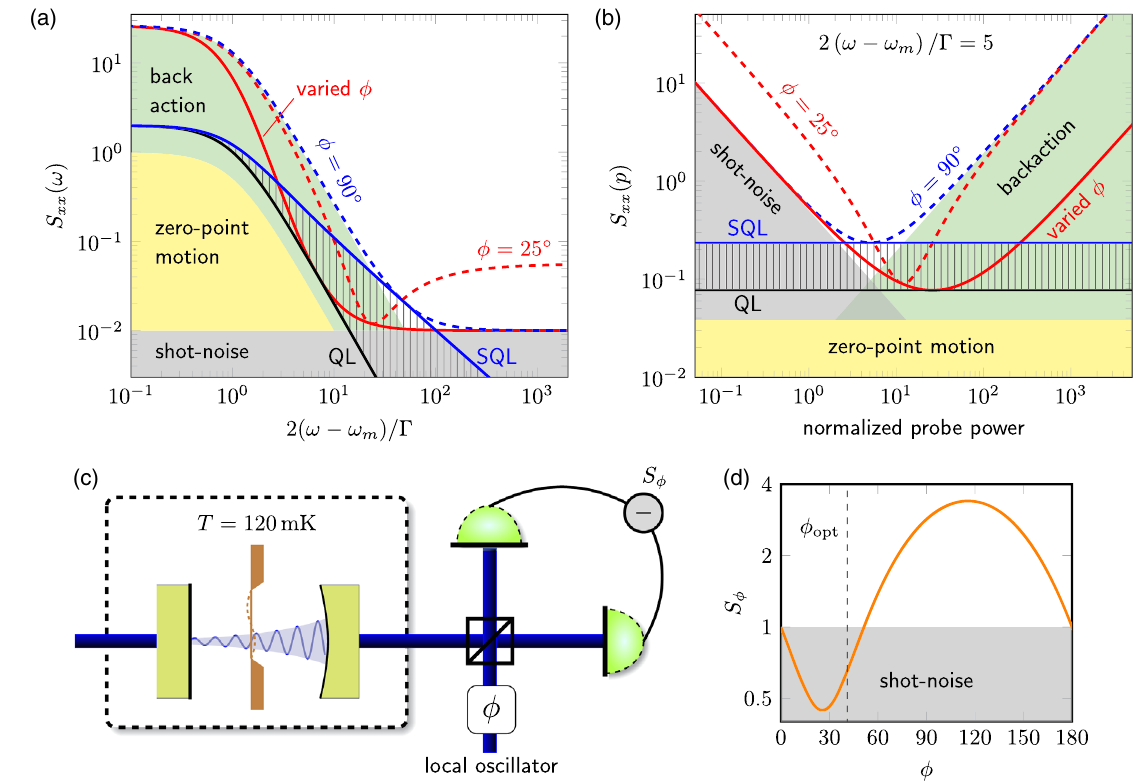
FIG. 1. Imprecision for different interferometric measurement configurations. (a) Frequency dependence for fixed power p ¼ 50 and = Γ ¼ 5 . Shaded areas represent the SN (gray), backaction (green), and zero-point (b) power dependence for frequency 2 ð ω − ω m Þ motion (yellow). Lines represent measurement at ϕ ¼ 90 ° (dashed blue), ϕ ¼ 25 ° (dashed red), variational readout (solid red). The black (QL) and blue (SQL) lines in both (a) and (b) show total limits when the probe power is allowed to vary to optimize total noise, with hatched area highlighting the QL and SQL distinction. All curves are evaluated for ideal quantum efficiency ϵ ¼ 1 and zero thermal disturbance. (c) Experimental schematic. Coherent probe beam enters the cavity and interacts with a membrane resonator. The probe light that leaves the cavity is detected via balanced homodyne detection with the measurement angle (quadrature) set by the local = Γ ¼ 5 and p ¼ 6 . Plotted is the spectral oscillator phase ϕ . (d) Comparison to ponderomotive squeezing for frequency 2 ð ω − ω m Þ density for the optical output S ϕ (orange line) compared to the shot-noise limit (shaded gray) (see Appendix). The dashed black line ) is shifted towards the phase quadrature compared to the demonstrates that the optimal mechanical displacement measuring angle ( ϕ opt phase for maximal ponderomotive